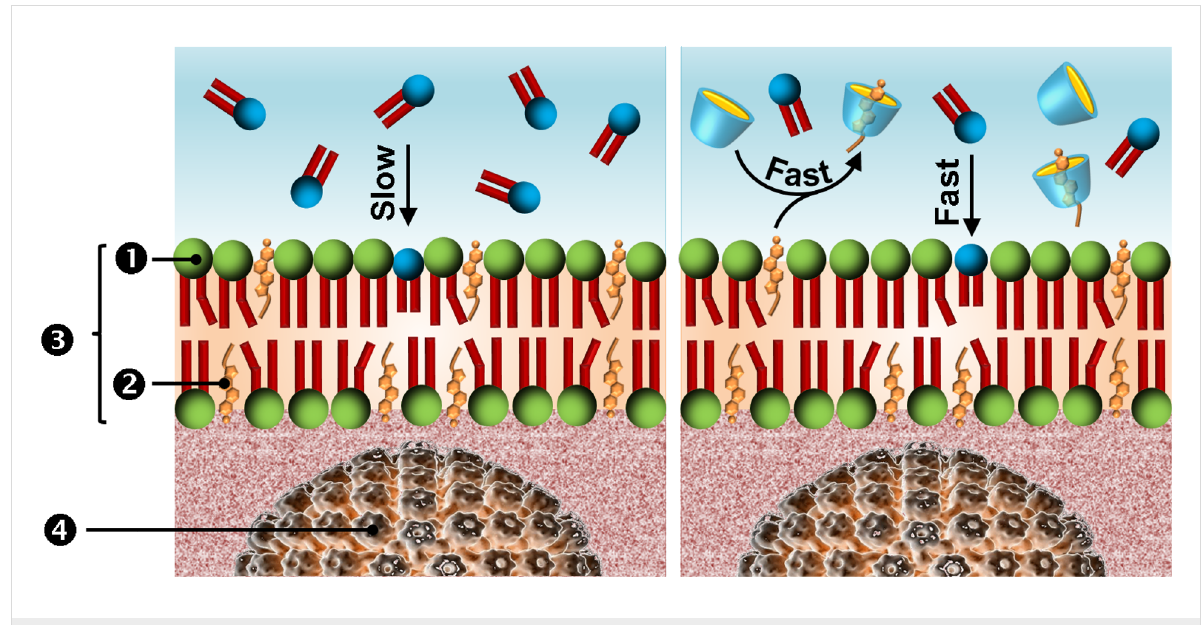
Scheme 7: Kinetics of [DiC 10 ] insertion into the viral envelope without (left) or with γ -CD (right). Note that, after this step, the presence of [DiC 10 ] cations induces morphological changes that enhance the envelope fluidity and lead to the virus inactivation after envelope disruption (1. phospholipid, 2. cholesterol, 3. envelope, and 4.